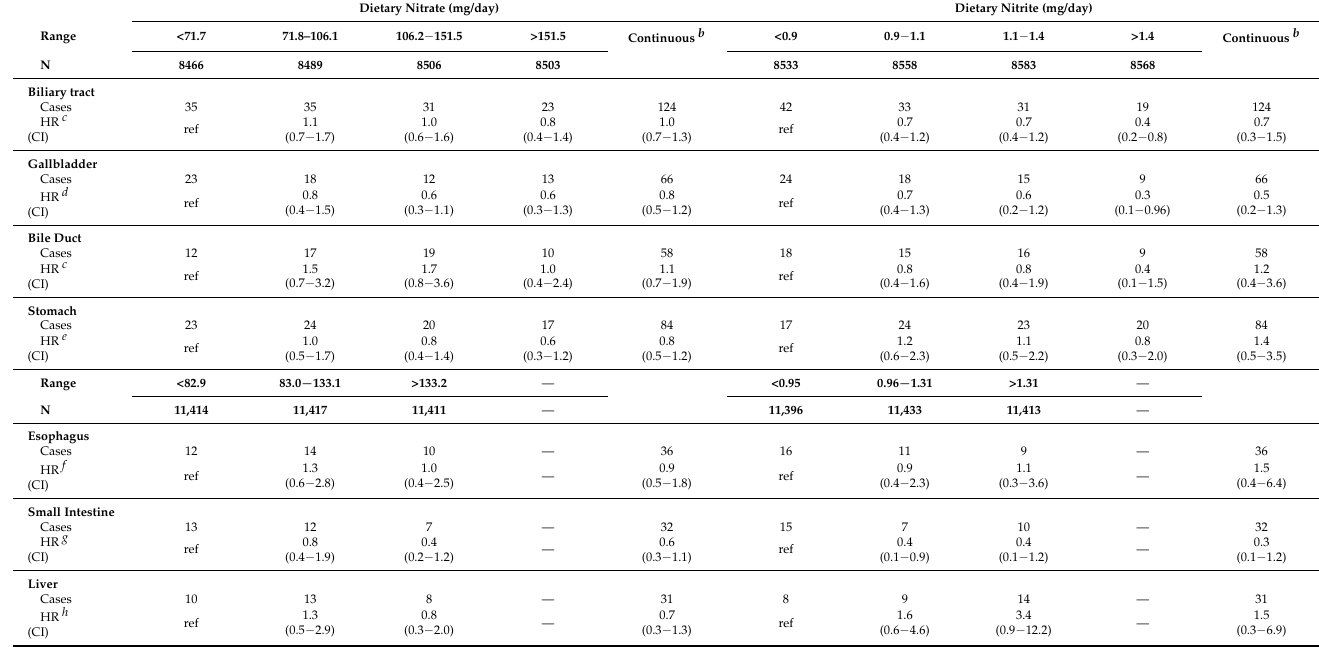
Table 2. Association between dietary nitrate and nitrite (mg/day) and specific digestive system cancers in the Iowa Women’s Health Study (N = 33,964). a Quartile groups for biliary tract, gallbladder, bile duct, and stomach cancers. Tertile groups for esophagus, small intestine, and liver cancers. DietaryNitrate(mg/day) DietaryNitrite(mg/day) Range <71.7